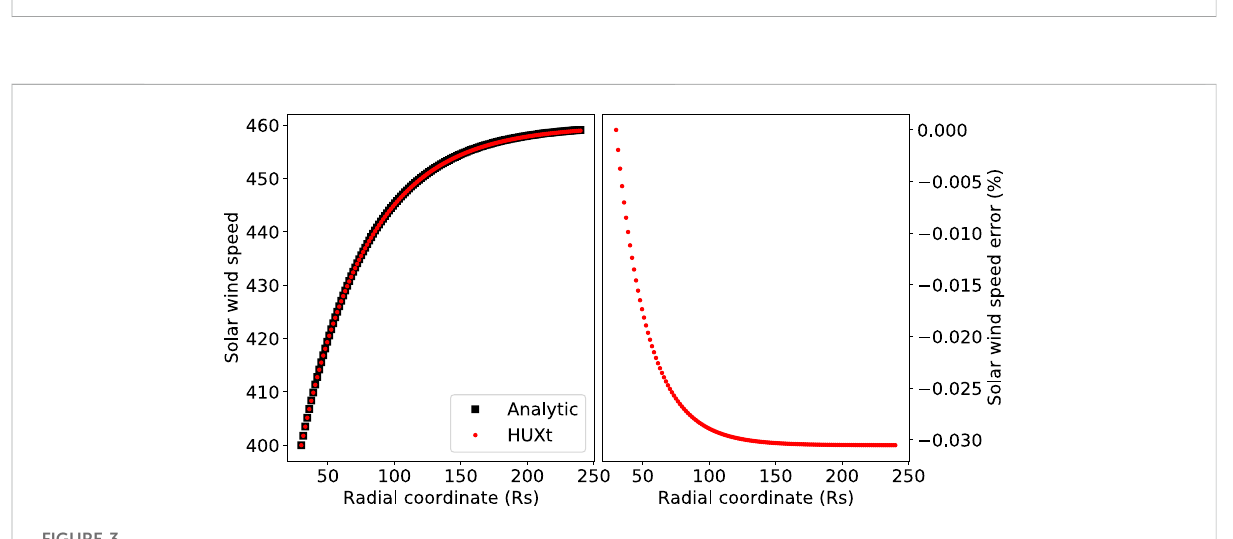
Comparison of the analytic and numerical solutions to the HUXt equations for a simpli fi ed scenario of uniform and stationary inner boundary conditions. (Left) The solar wind speed as a function of radius for the analytic (black) and HUXt solutions (red). (Right) The percentage error of the HUXt solution relative to the analytical solution as a function of